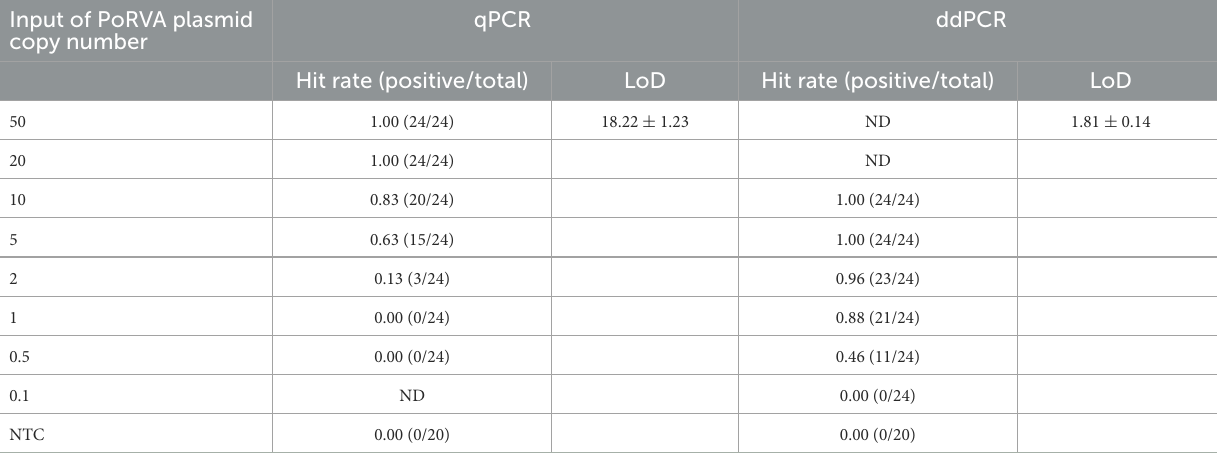
TABLE 2 Detection limits of quantitative real-time PCR (qPCR) and droplet digital PCR (ddPCR). Input of PoRVA plasmid copy number